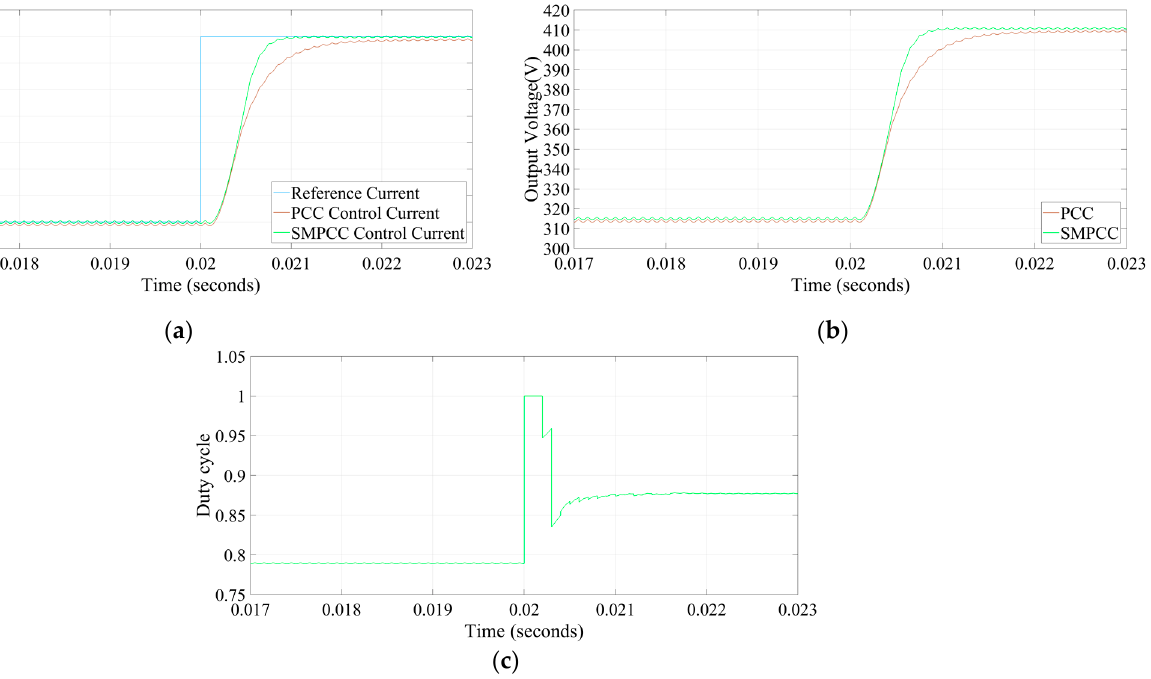
Figure 4. The simulation when output reference current abruptly increases. ( a ) The output current changes; ( b ) The output voltage changes; ( c ) The duty cycle changes of M1 and M4 in SMPCC.